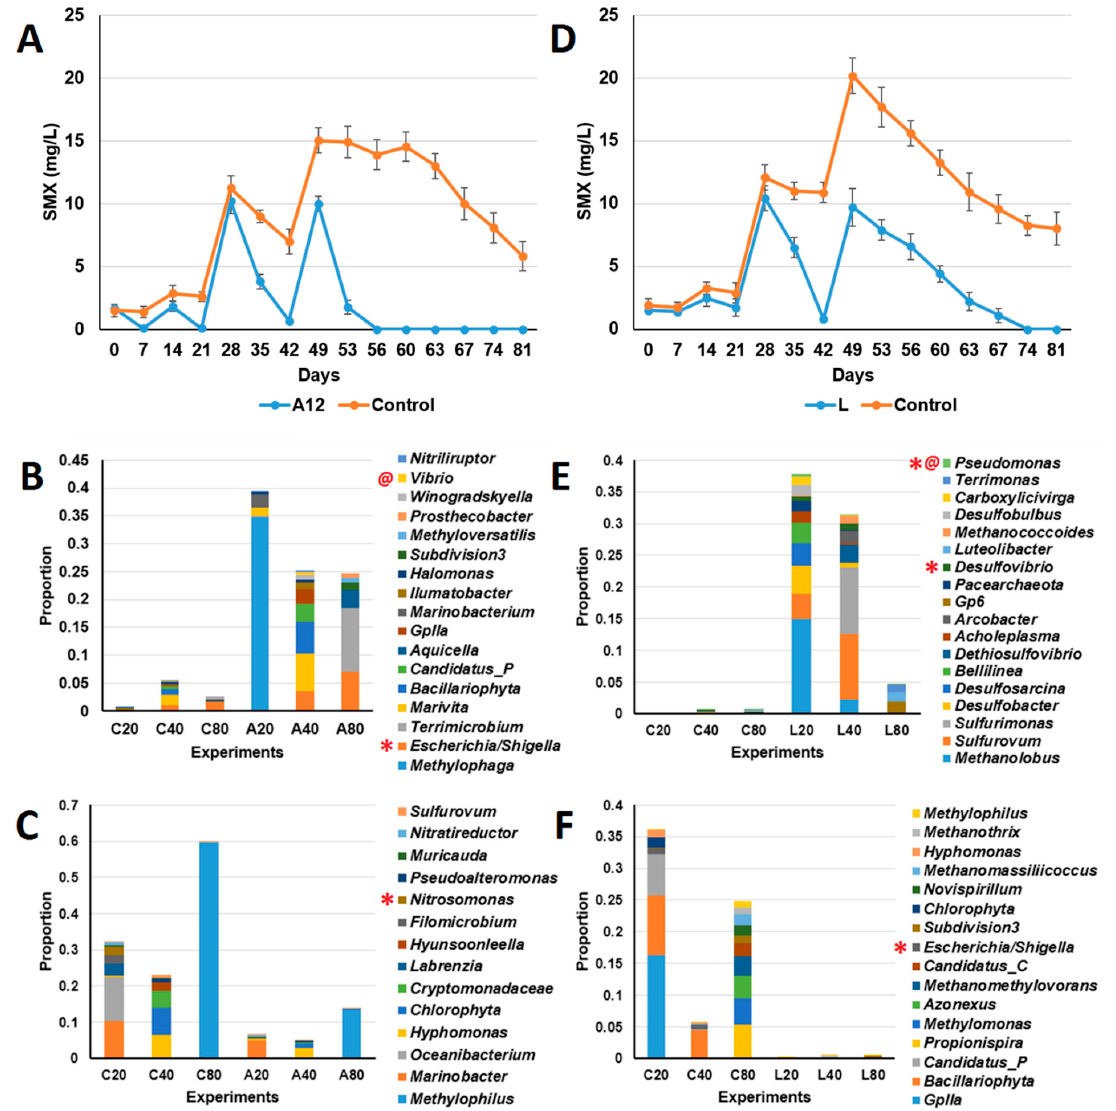
Figure 8. Biodegradation of sulfamethoxazole (SMX) by bacterial strains A12 and L (with fish pond sediments) in aerobic and anaerobic readdition experiments, respectively. ( A ) Aerobic SMX biodegradation with / without strain A12. ( B ) Major representatives of the microbial community in aerobic experiments with strain A12. ( C ) Major representatives of the microbial community in aerobic experiments without strain A12. ( D ) Anaerobic SMX biodegradation with / without strain L. ( E ) Major representatives of the microbial community in anaerobic experiments with strain L. ( F ) Major representatives of the microbial community in anaerobic experiments without strain L. Red stars indicate that SMX-degrading bacteria have been reported. Red “@”s indicate SMX-degrading bacteria isolated in this study. Proportions of microbes with a statistically significant difference between experiments with and without bacterial strains A12 and L were identified using the Mann–Whitney U-test ( p < 0.05).